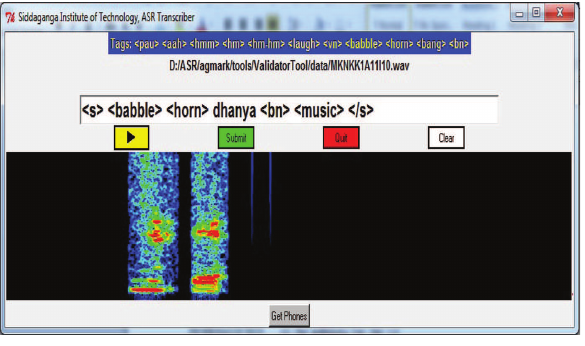
Figure 6: Validation Tool to Validate the Transcribed Speech Data. Table 14: The Labels Used from the Indic Language Transliteration Tool (IT3 to UTF-8) for Kannada Phonemes. Label set using IT3: UTF-8